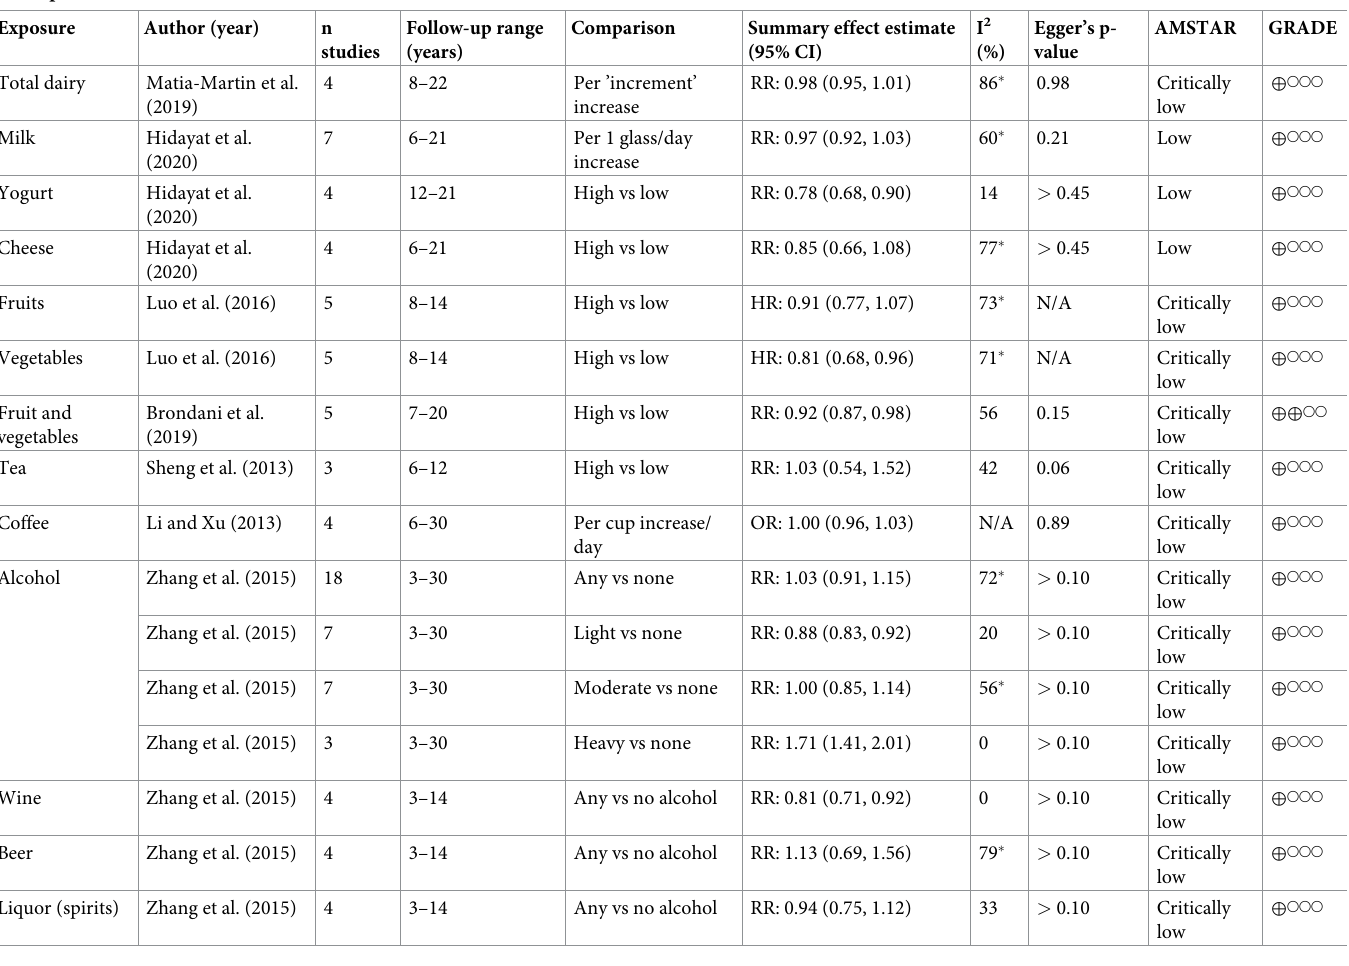
Table 2. Summary characteristics and findings of meta-analyses of cohort studies assessing associations between dietary intake of foods, food groups, and beverages and hip fracture